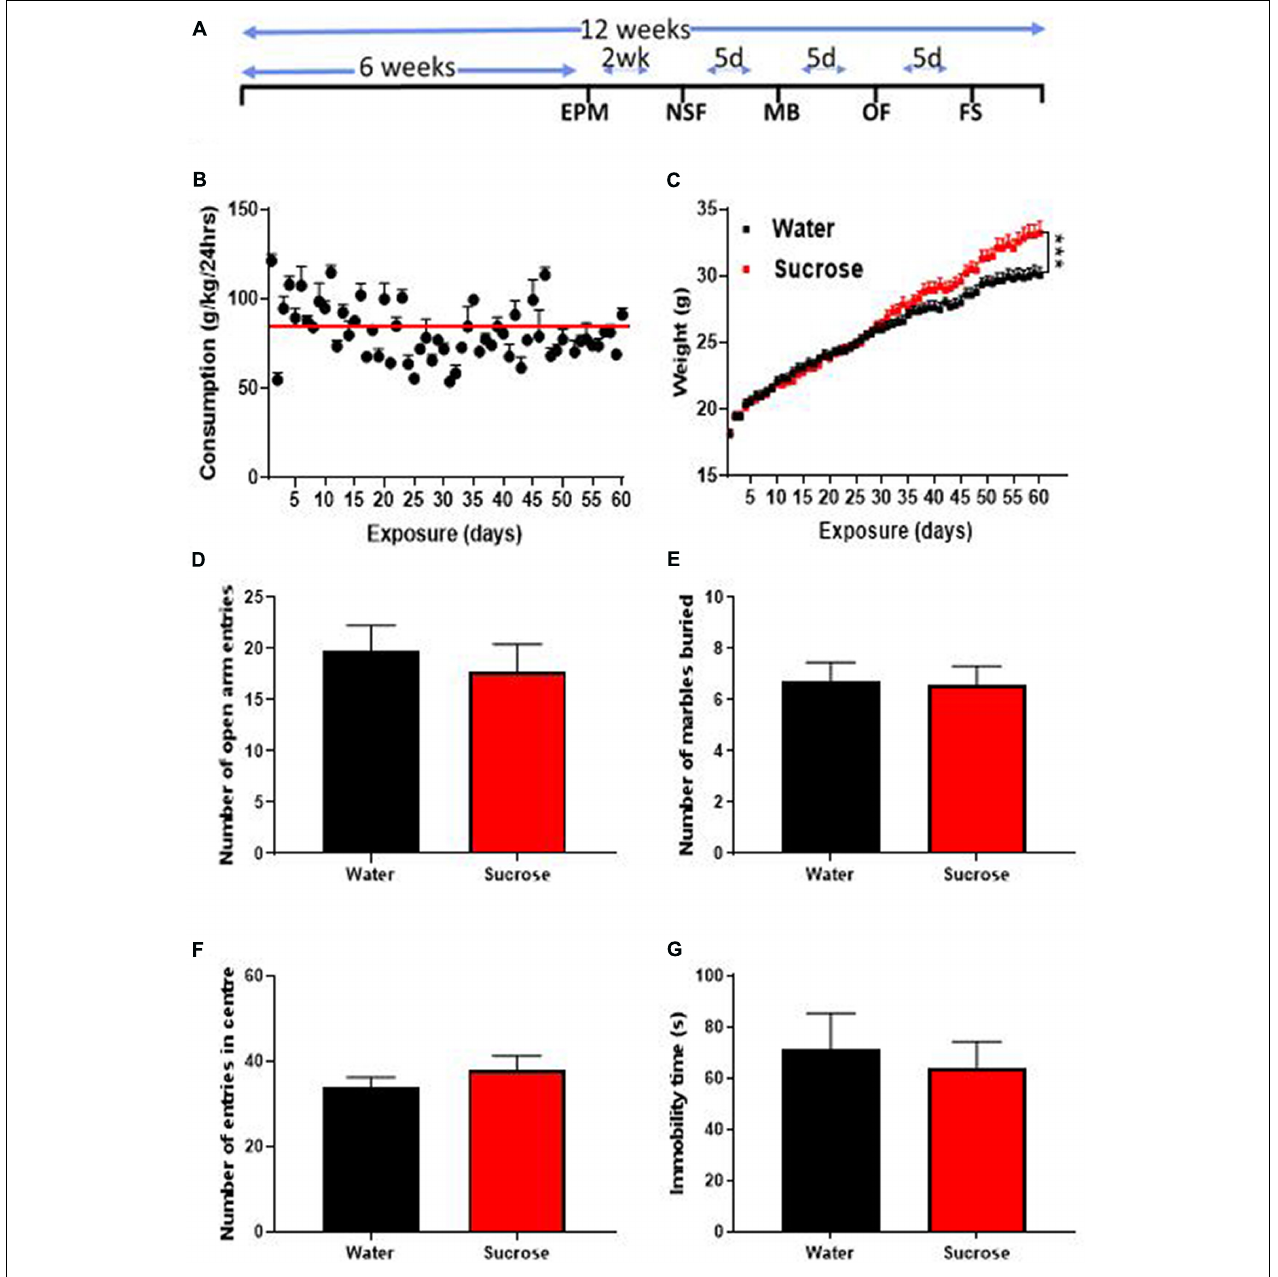
FIGURE 1 | Long-term sucrose consumption increases mouse weights without altering emotional behavior. (A) Experimental design of the anxiety-related, depression-related, general locomotor activity and impulse control behavioral testing in elevated-plus-maze (EPM), novelty suppressed feeding (NSF), marble burying (MB), open field (OF) and forced swimming test (FS). Animals consumed 25% sucrose for 5 weeks prior to each behavioral testing and continued to be exposed to sucrose for a total of 12 weeks. Behavioral tests were initially conducted 2 weeks (2 wk) then continued every 5 days (5d) after 24 h of sugar withdrawal. Animals were assigned into two groups: sugar-withdrawn animals and water control. (B) Mice exhibit stable levels of long-term sucrose intake of 82.2 ± 0.9 g/kg indicated by the red line. (C) There was a significant difference in the weights of animals consuming sucrose, compared to water control, starting after 4 weeks, and continuing throughout the 12 weeks. Data are presented as mean ± SEM; n = 8 mice/group, t -test, *** p < 0.001. (D–F) Long-term sucrose consumption does not alter anxiety-related behavior as seen by no change in the number of entries in the open-arm of the EPM (D) , number of marbles buried (E) and number of entries in the center in the open field (F) compared to water controls. Long-term sucrose consumption does not induce depressive-like symptoms as seen by no differences in the immobility time in the forced swimming test (G) compared to water controls. Data are presented as mean ± SEM; n = 8 mice/group.